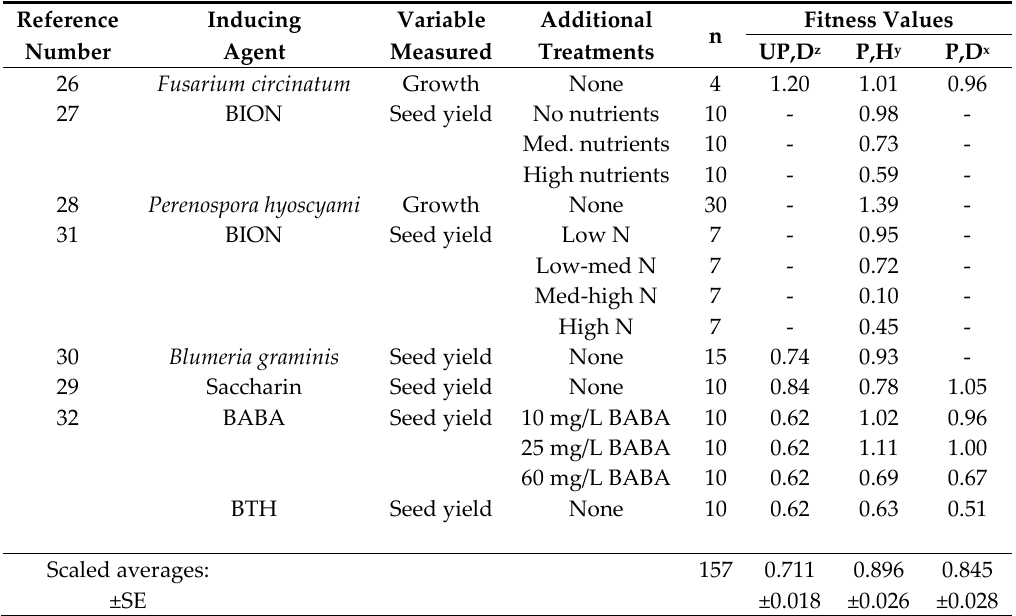
Table 1. Meta-analysis of fitness costs or benefits of salicylic acid-mediated induced resistance to chemical or biological inducers in various plant species in presence or absence of pathogen pressure.